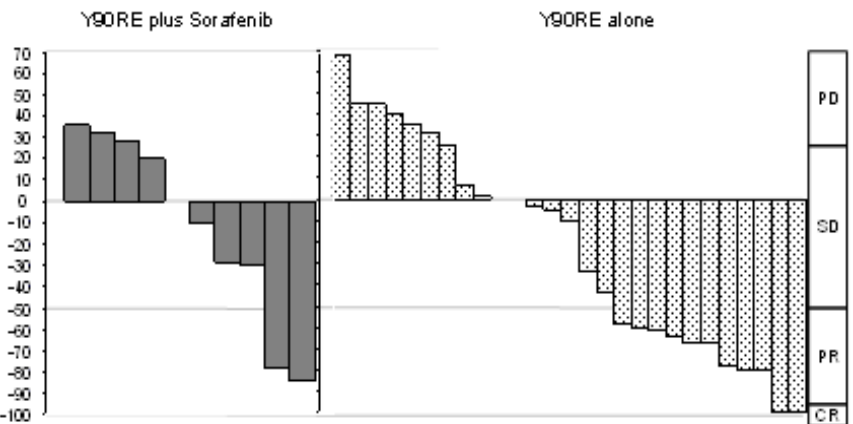
Figure 4. Waterfall graphic representing the tumor response rate in the two groups. CR, complete response; PD, progressive disease; PR, partial response; SD, stable